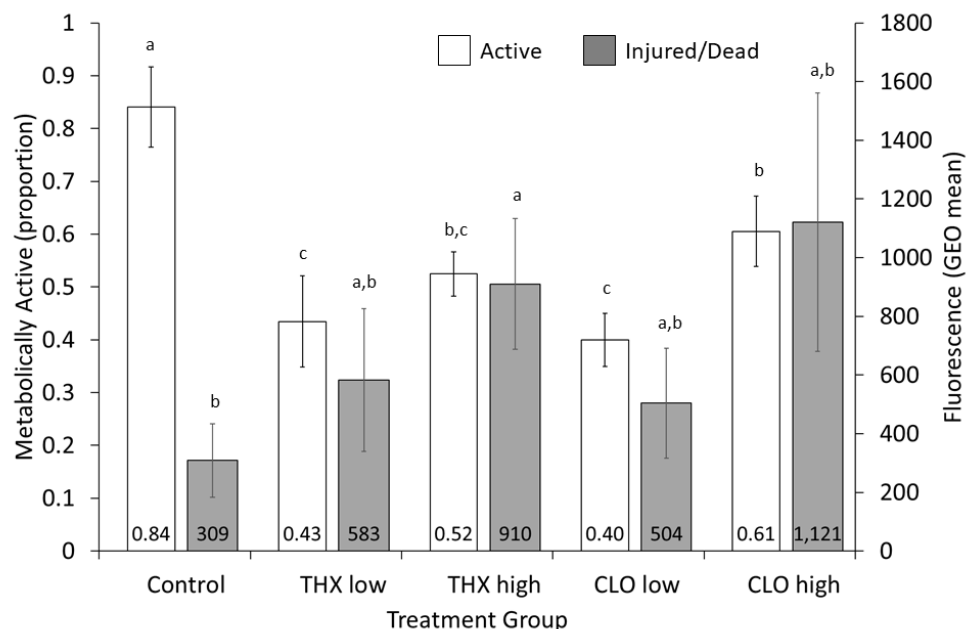
Figure 5. Flow cytometric data on the proportion of reductase activity and the cytotoxicity of the dead and injured cell populations from livers of Xenopus laevis tadpoles exposed for 44 days in neonicotinoid-free control media, or in either thiamethoxam (THX) or clothianidin (CLO) treatment groups at 20 and 100 ppm, or low and high, respectively. From 3 to 7 flow cytometric analyses were performed on 5 livers pooled per treatment ( n = 24 total analyses). Data were collected 24 h after tadpoles were removed from the treatment and placed into neonicotinoid-free media. Letters represent differences among treatment groups per bar color (reductase activity, p < 0.0001; cytotoxicity, p =